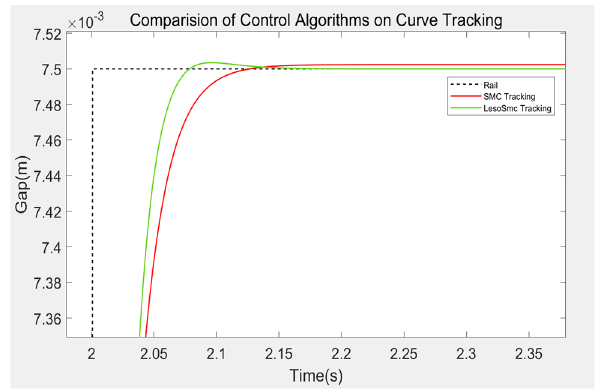
Figure 15. Partial enlarged view of curve tracking under different control algorithms.